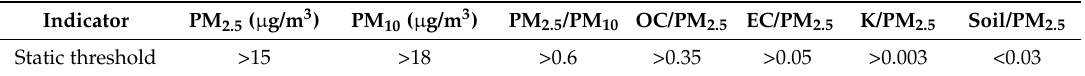
Figure 3. Comparison of fire identification criteria values during fire conditions and average background concentrations or conditions sampled by the monitoring site. Table 1. Thresholds of fire identification criteria used in this study.